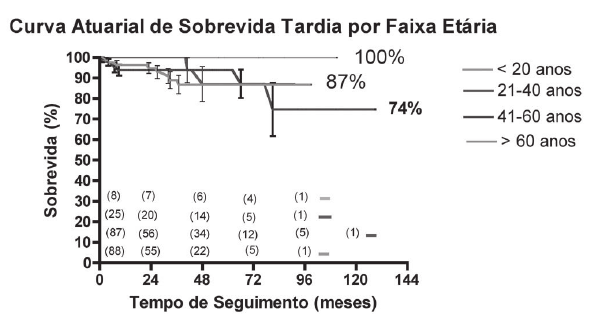
Fig. 3 - Curva atuarial de sobrevida estratificada por faixa etária, em 282 pacientes submetidos à substituição da valva aórtica por homoenxerto valvar aórtico.